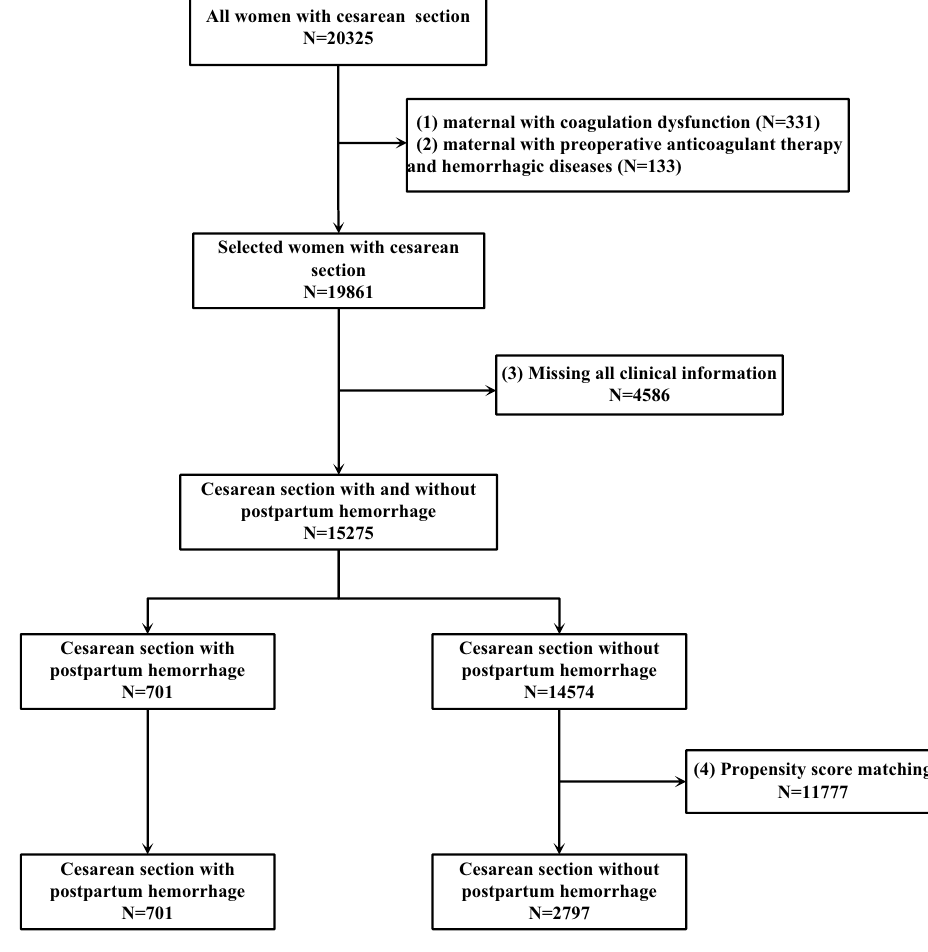
Figure 1. Flowchart for screening study